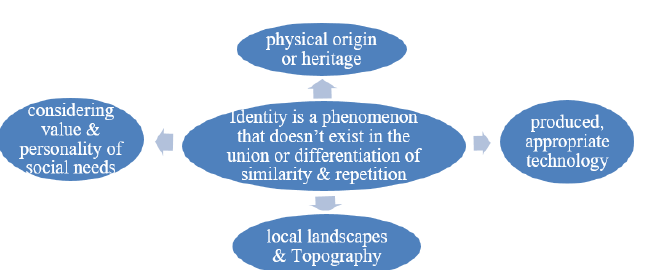
Figure 3. The major four affective elements in forming the identity